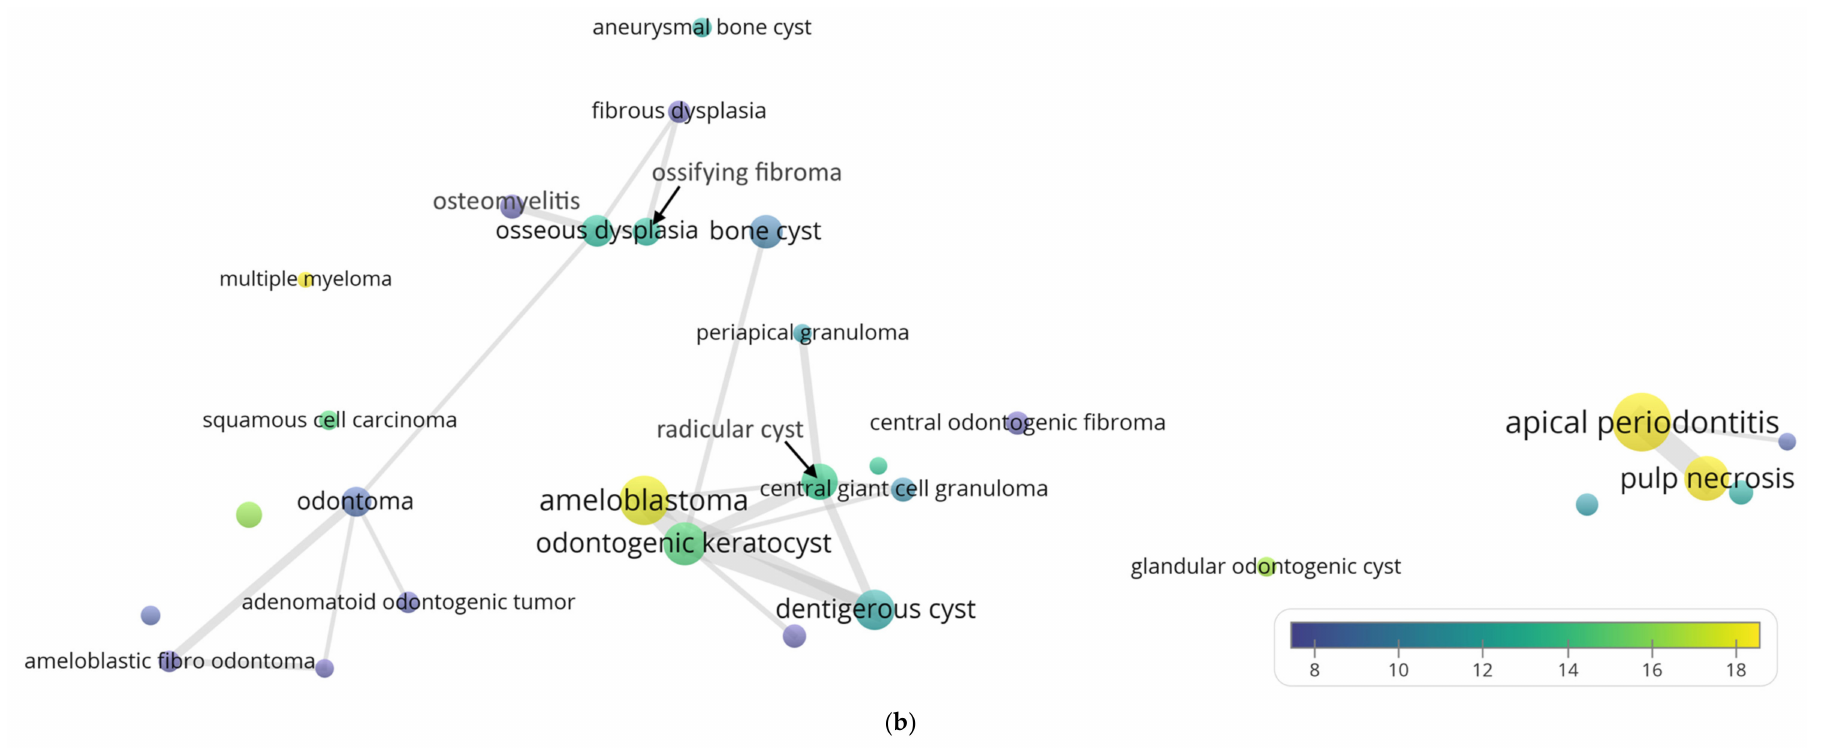
Figure 1. ( a ) Recurring radiolucent lesions mentioned in the title and abstract of the analyzed papers. ( b ) A simplified illustration that only connects lesions that co-occurred at least 4 times (the size variation of the lines was enhanced for